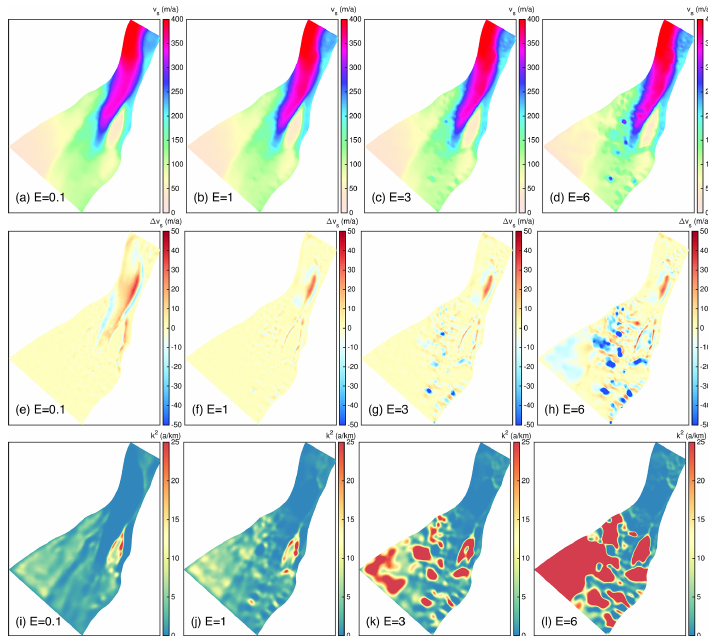
Figure A1. Overview of the ISSM inversion performed with the different values for E = 0 . 1, 1, 3 and 6 at the ice-stream region. (a–d) Simulated surface velocities. (e–h) Velocity difference between observed and simulated velocities. (i–l) Inferred basal friction coefficient k 2 .